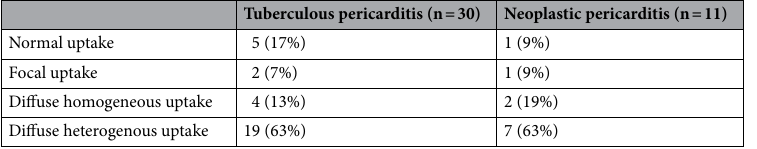
Table 5. Difference in the shape and properties of 18 FDG accumulation between tuberculous pericarditis and neoplastic